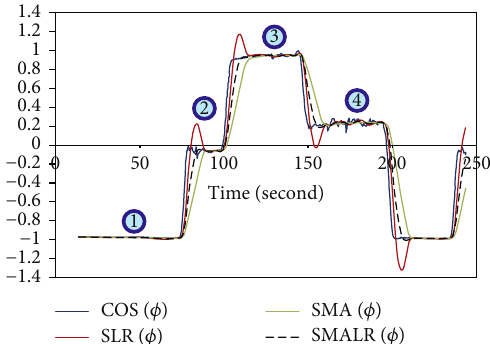
Figure 7: Plots for the original and fi ltered cosine outputs of the heading angle ( ϕ ) measured by the digital compass, i.e., cos ð ϕ Þ , SLR ð cos ð ϕ ÞÞ , SMA ð cos ð ϕ ÞÞ , and SMALR ð cos ð ϕ ÞÞ , versus time for the MST system travelling a round trip following the map illustrated in Figure 6.